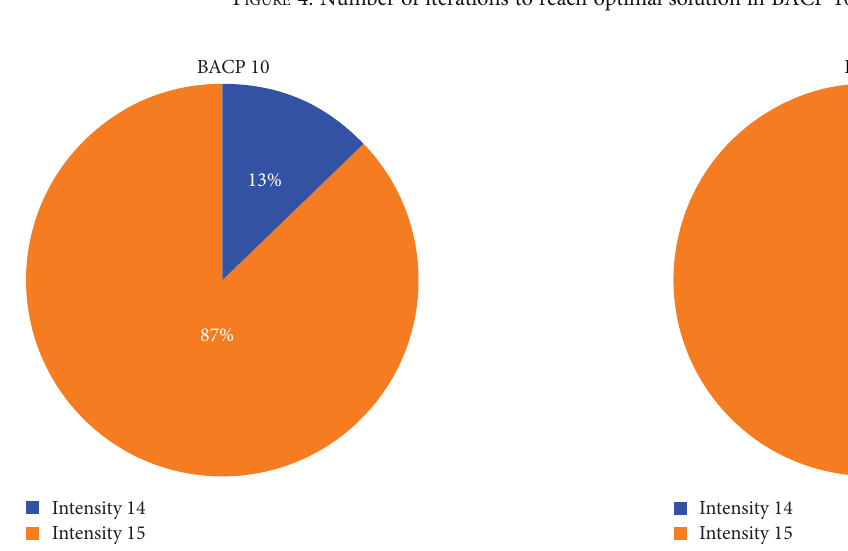
F IGURE 6: BACP 10 result distribution with local search